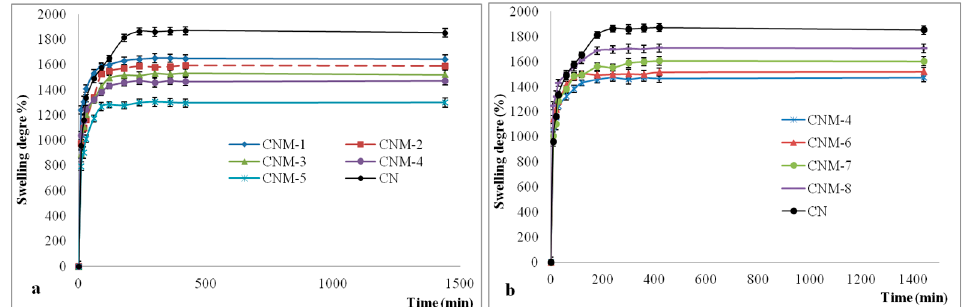
Figure 8. The swelling kinetics curves of the NCs in alkaline conditions (pH 7.4) for the following